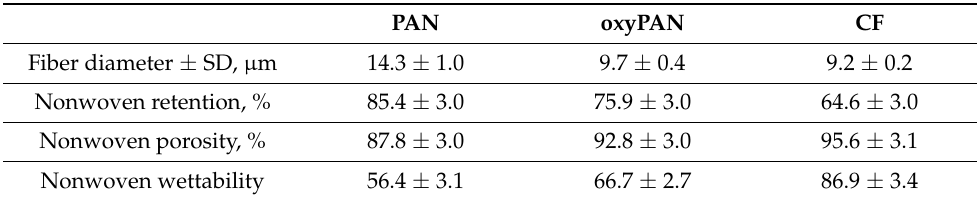
Table 1. Characterization: fiber diameter, nonwoven porosity, and wettability of nonwovens obtained from PAN fibers, stabilized precursor (oxyPAN), and carbon nonwovens obtained after carbonization process (CF). PAN oxyPAN